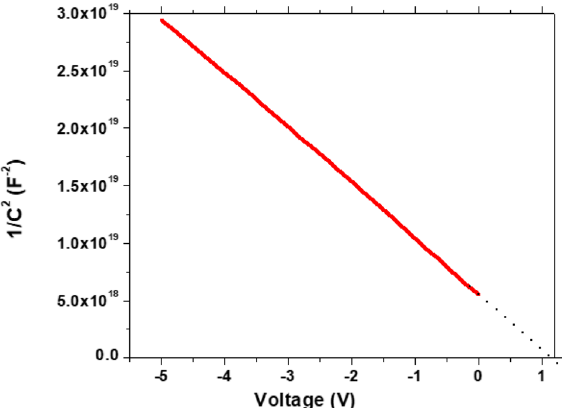
Figure 6. The 1/C 2 vs V plot of the GaN-1 wafer.